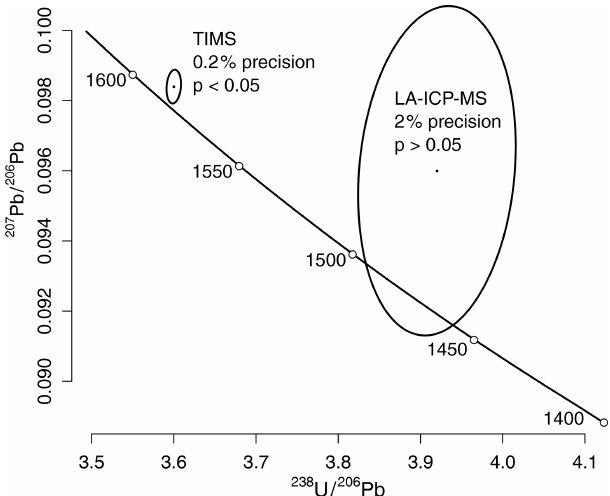
Figure 4. Application of the flawed p value discordance criterion to two synthetic measurements by TIMS (left) and LA-ICP-MS (right). The precise TIMS measurement is labelled as discordant even though it plots closer to the concordia line than the imprecise LA-ICP-MS measurement, which is labelled as